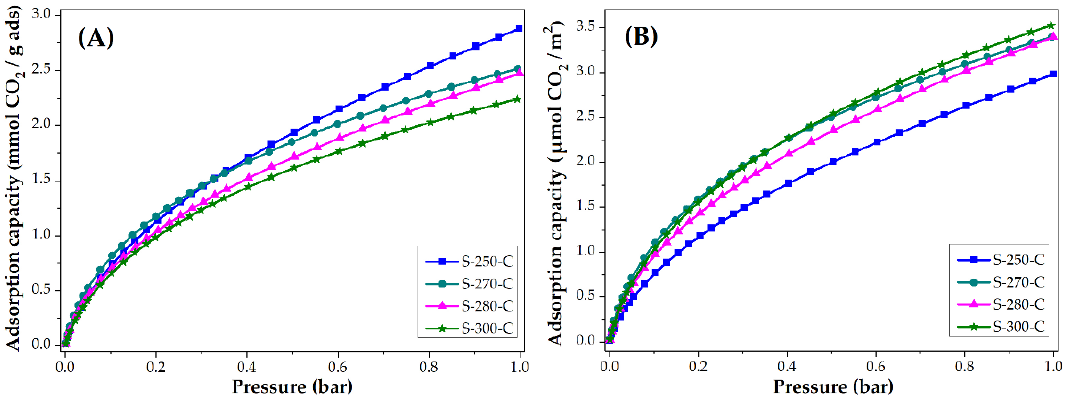
Figure 4. CO 2 adsorption isotherms of CMF: ( A ) mmol CO 2 / g adsorbent and ( B ) µ mol CO 2 / m 2 .